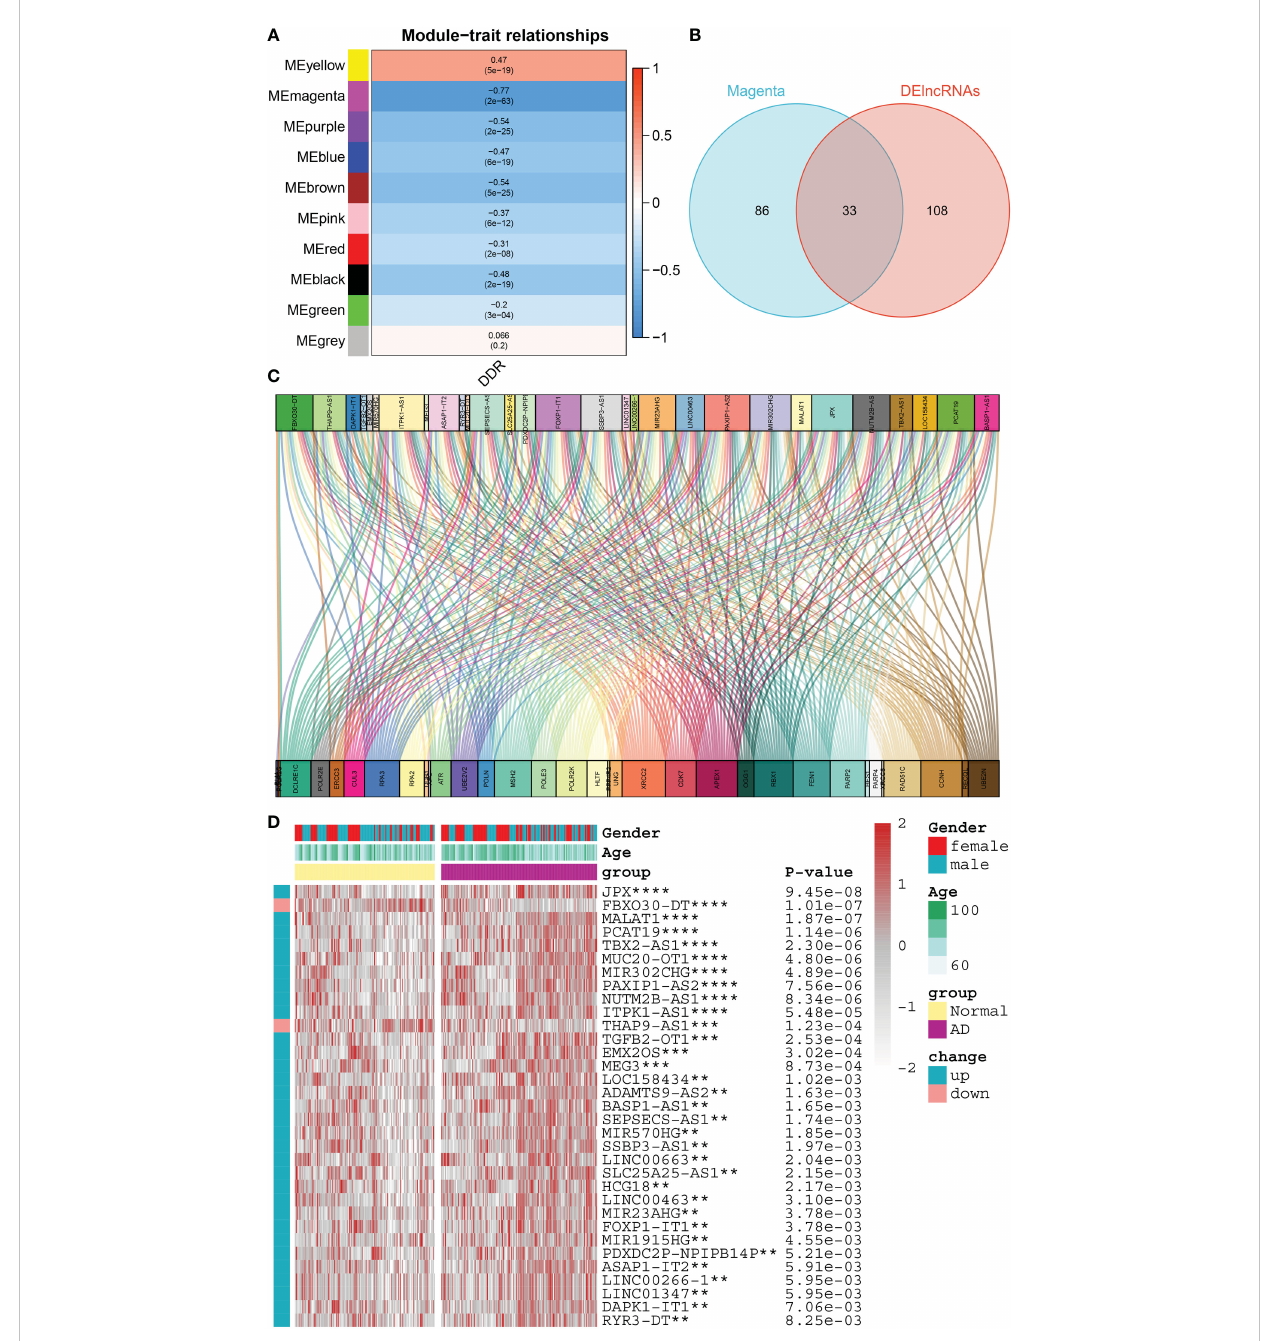
FIGURE 5 Identi fi cation of DDR-associated lncRNAs. (A) Heatmap representing the association between 10 modules with DDR score. (B) The intersecting DDR- associated lncRNAs shared by the magenta module and the DElncRNAs in the combined dataset were shown in a venn diagram. (C) The Sankey diagram exhibiting the correlation between differentially expressed DDR regulators and 33 lncRNAs. (D) Comparison of the expression pro fi les of 33 DDR- associated lncRNAs across AD and normal brain tissues in combined dataset using a heatmap. **p < 0.01, ***p < 0.001, ****p <